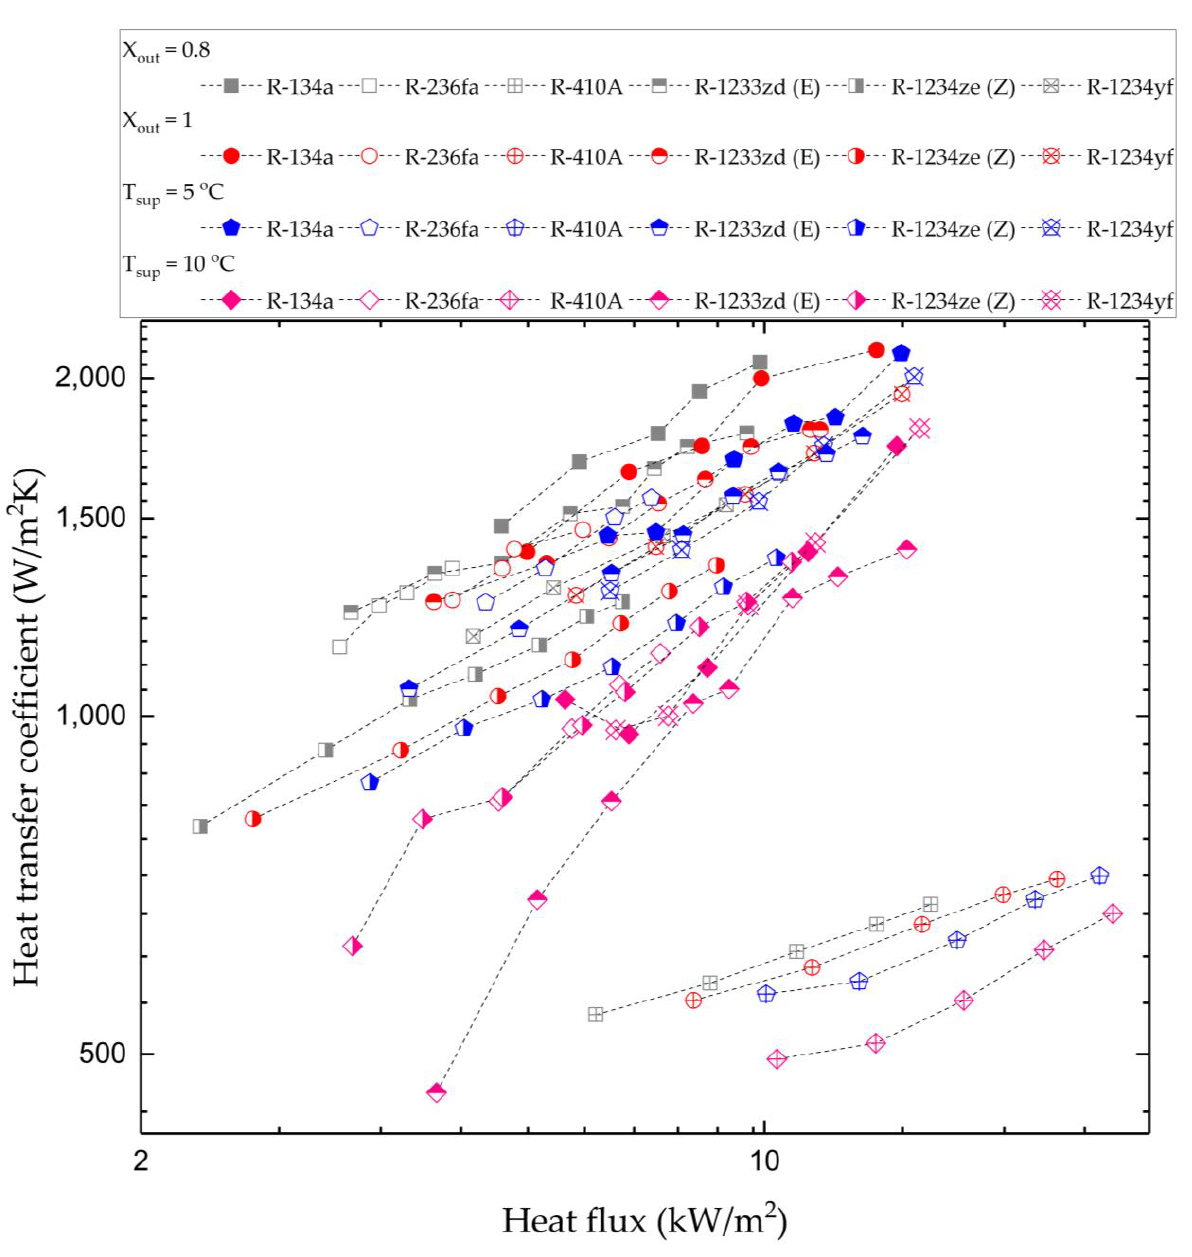
Figure 23. Influence of average HTCs on the refrigerant side and heat flux for a saturation temperature of 10 °C [6,9,10,16,106,107] .